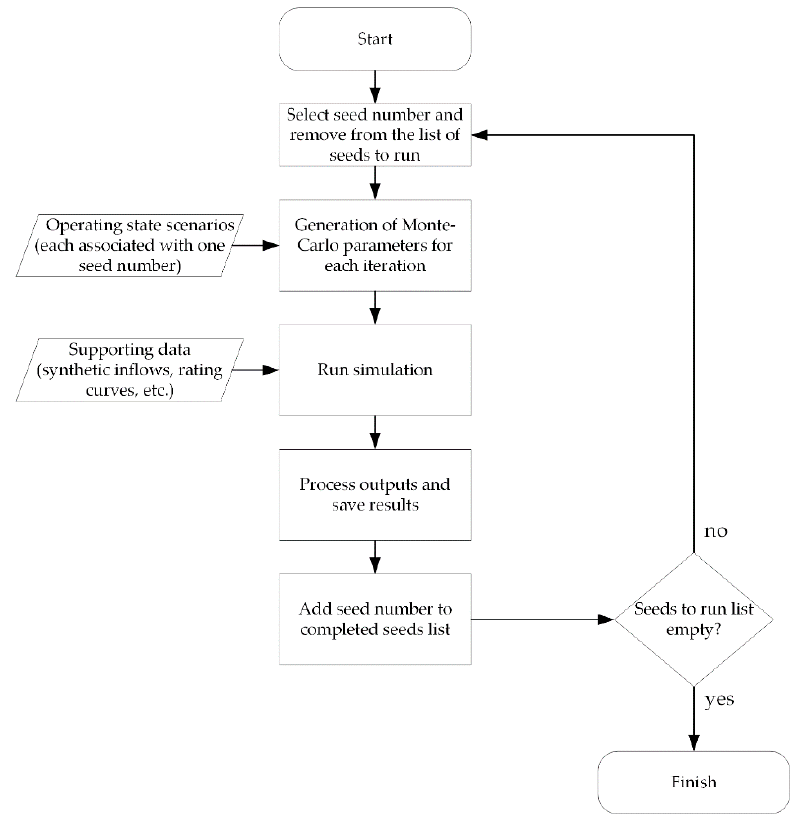
Figure 11. Simulation flow chart.